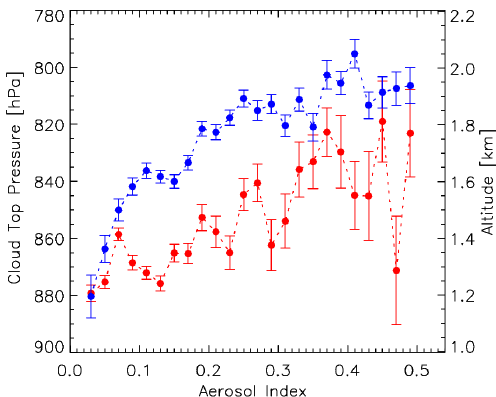
Fig. 14. Cloud Top Pressure (CTP) retrievals averaged over constant bin of Aerosol Index (AI), in linear scale, for cases of well separated (blue) and mixed (red) cloud-aerosol layers, in the region within [2 ◦ S–15 ◦ S; 14 ◦ W–18 ◦ E]. The error bars indicate the statistical uncertainties as in Fig. 5.